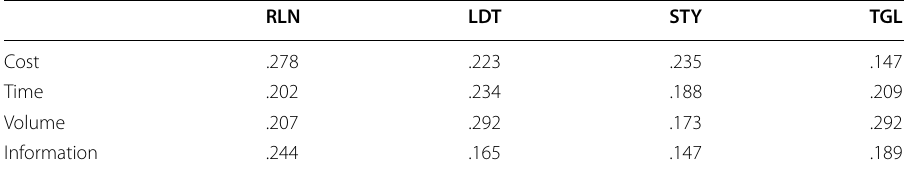
Table 13 Score function values of the strategies